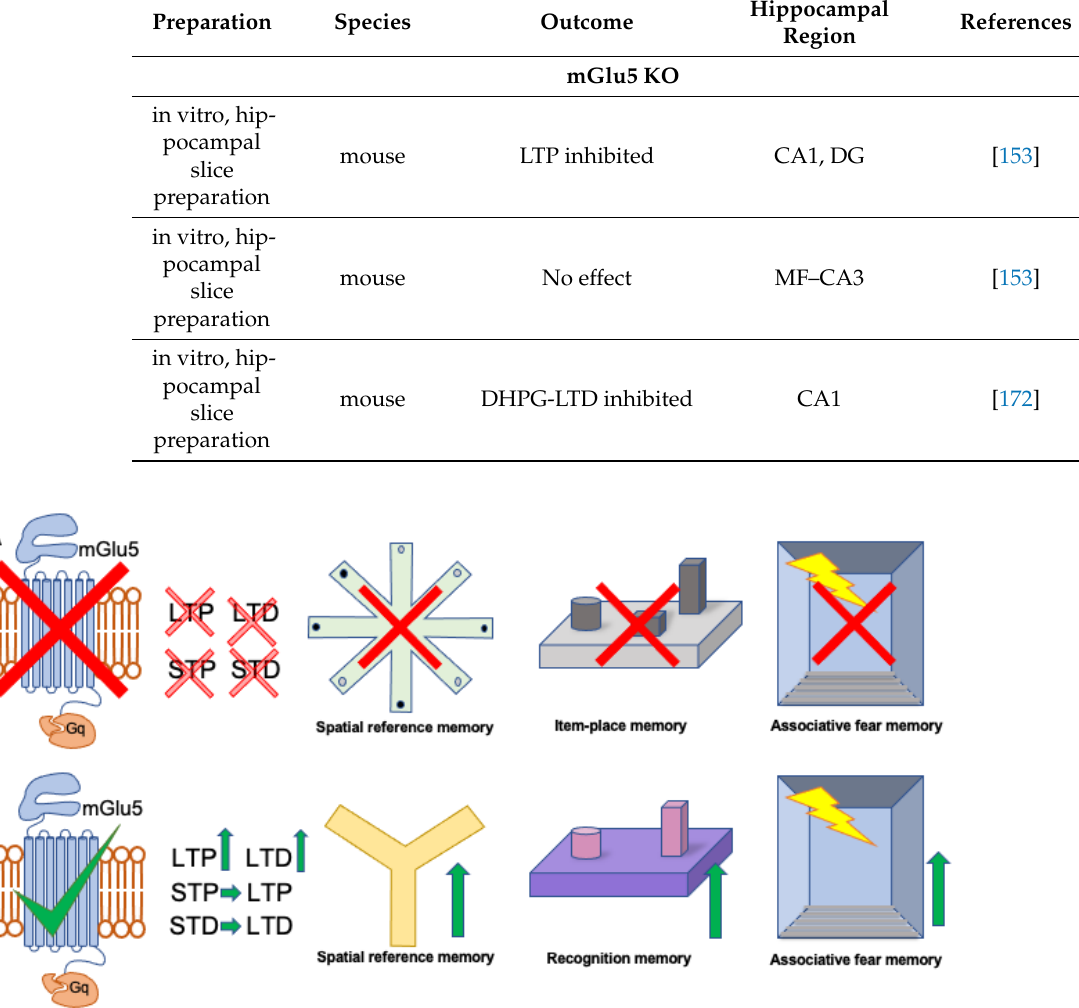
Figure 1. Schema of the effects of pharmacological antagonism, or agonism, of mGlu5 receptors on hippocampal synaptic plasticity and hippocampus-dependent forms of learning and memory. ( A ) Pharmacological antagonism of mGlu5 receptors prevents the maintenance of both LTP and LTD. STP and STD are also impaired. Prior treatment with an mGlu5 receptor antagonist prevents spatial reference memory in paradigms such as the 8-arm radial maze, prevents effective item-place memory and disrupts associative fear memory. ( B ) Pharmacological activation of mGlu5 receptors strengthens and prolongs LTP and LTD and also facilitates short-term plasticity (STP, STD) into long-term plasticity (LTP, LTD respectively). Spatial learning in paradigms such as the Y-maze is enhanced, recognition memory is improved, as is associative fear memory. For relevant literature, see Tables 1 and 2. The red cross signifies inhibition/impairment. The green tick signifies activation, and the green arrows signify enhancement.